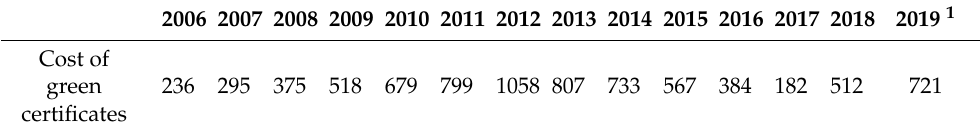
Table 5. Cost of support for renewable electricity generation in Poland, EUR 10 6 .